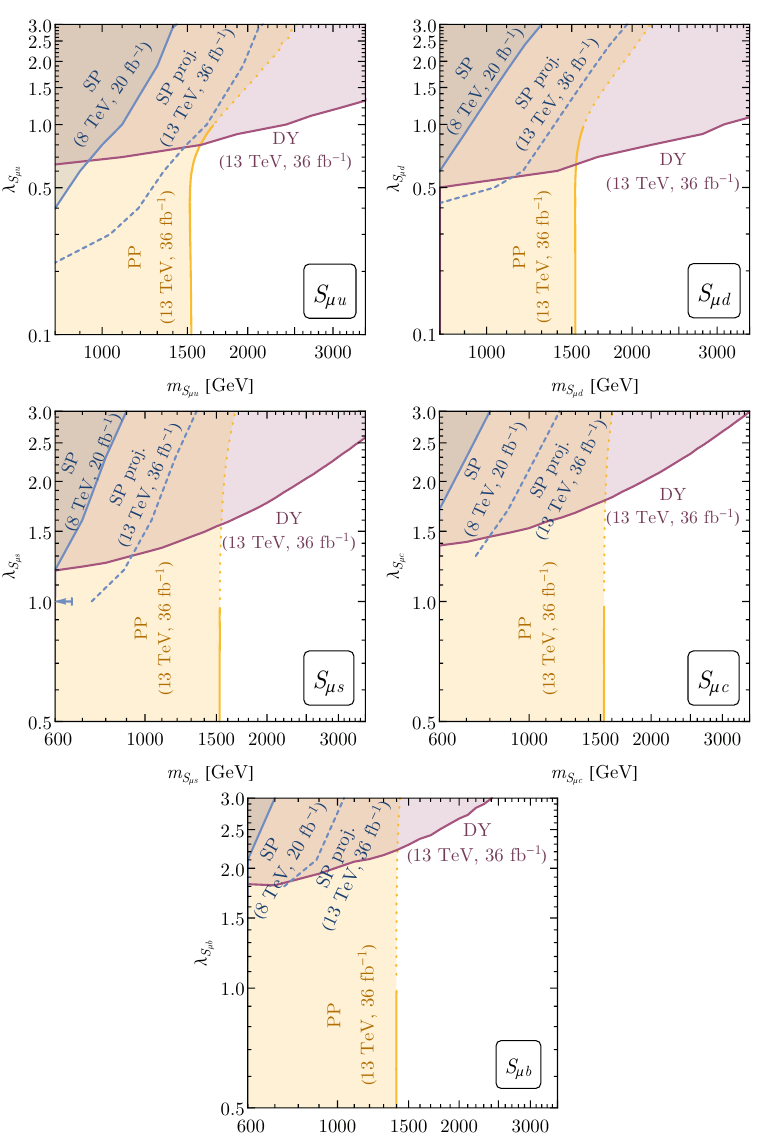
Figure 9. 95% CL limits on the parameter space for scalar MLQ S (cid:22)q ( q = u; d; s; c; b ). The pair- production (PP) limits are recast from [58]. The single-production (SP) limits are recast from a Run 1 search [17] with our projections for the Run 2 reach, and DY limits are based on [13]. The arrow in the S (cid:22)s plot shows the bound directly given by